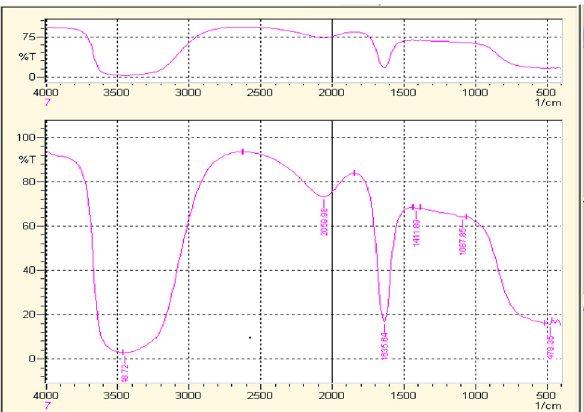
Figure 8: FTIR spectrum water nanoparticles of Tropaeolum majus .